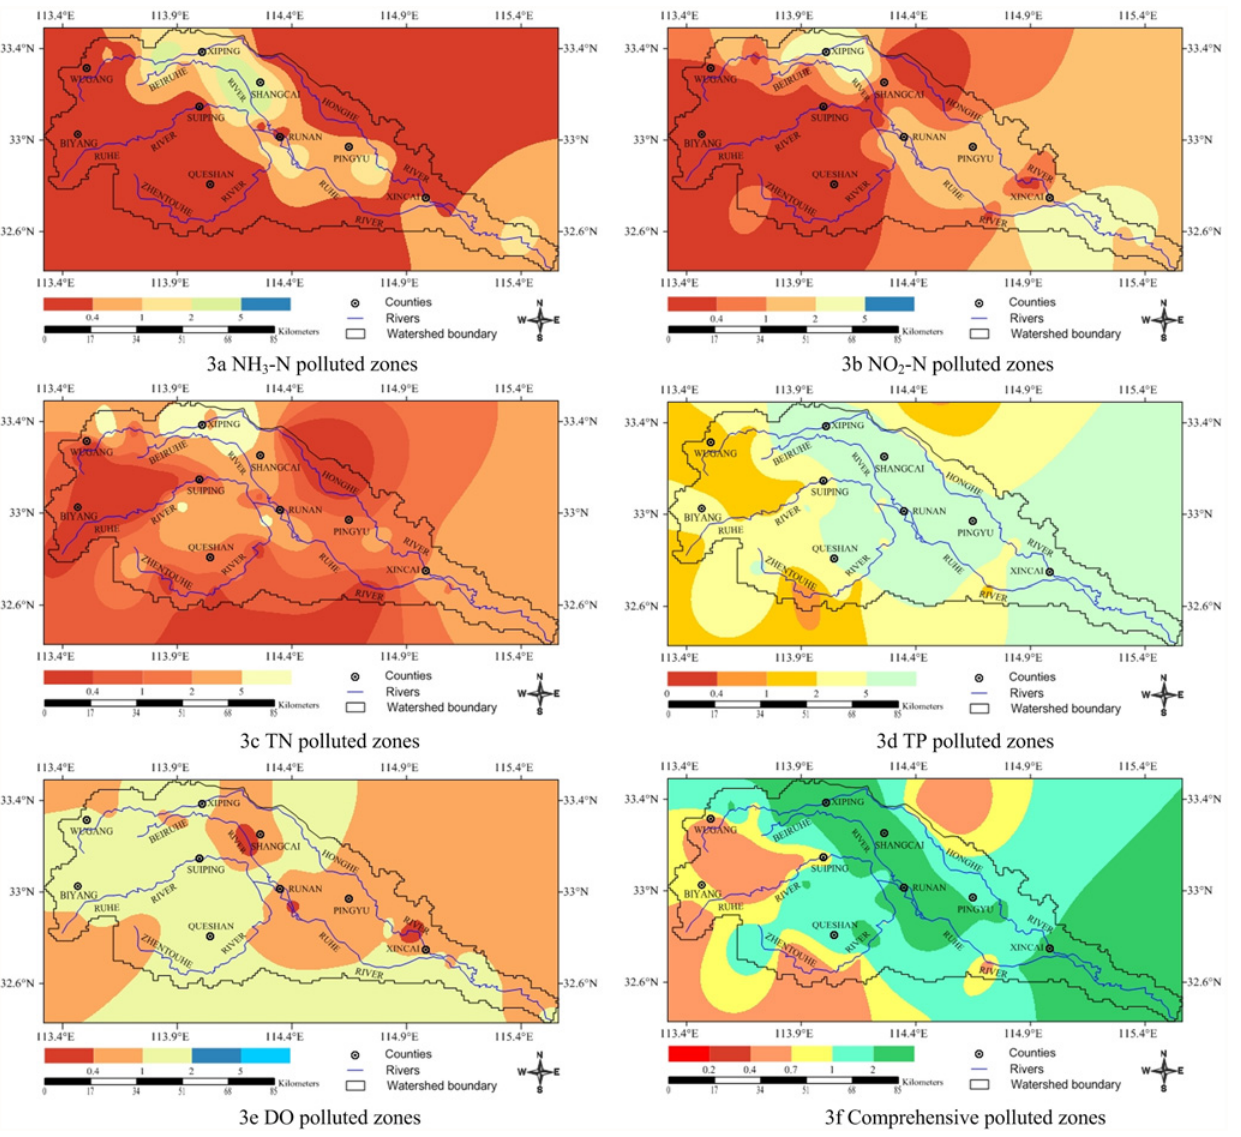
Fig 3. The spatial pattern of the polluted and risky vulnerable zones across the Honghe River Watershed based on pollution index.